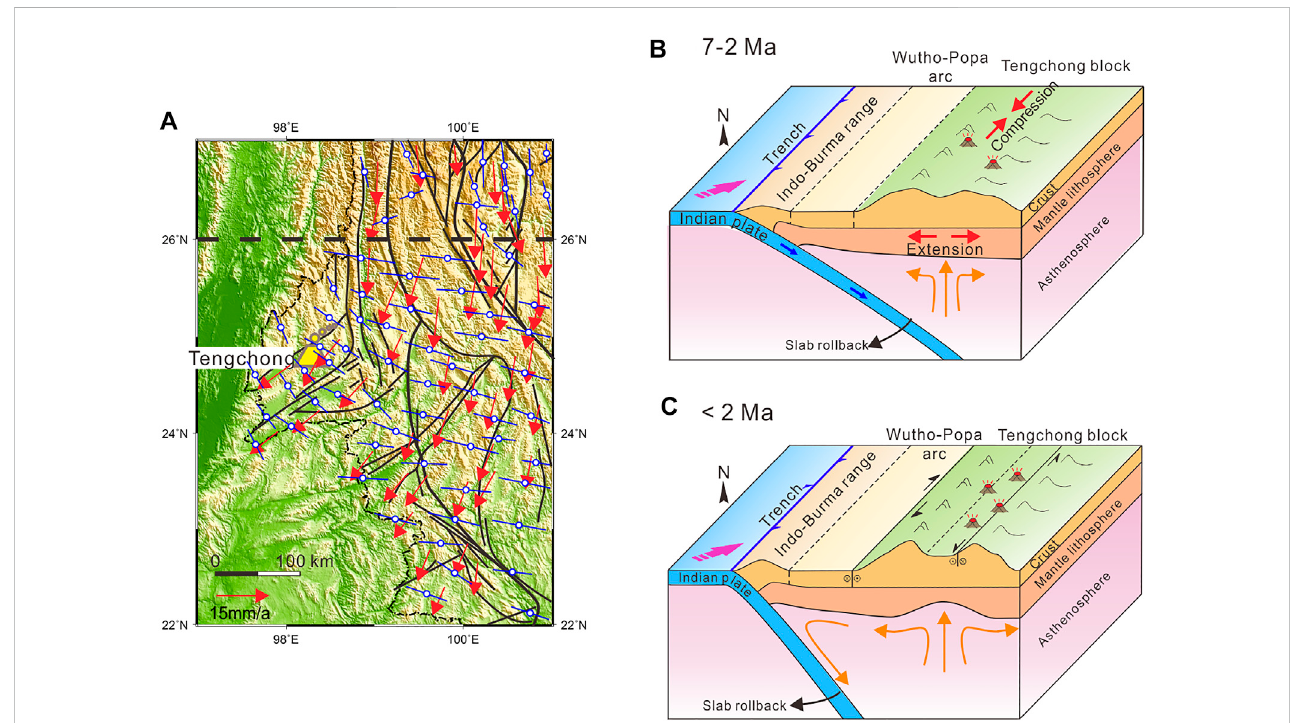
FIGURE 11 (A) Diagrams comparing GPS velocity vectors (red arrows; Wang, 2009) and average XKS fast orientations (blue bars; Gao et al., 2020). The black dashed line (~26 ° N) shows the inferred transition of mantle anisotropy in this area, and black lines denote major faults. (B,C) Schematics of crust – mantle decoupling beneath the Tengchong volcanic fi eld. The eastward underthrusting of the Indian plate following India-Asia collision at 55 – 50 Ma has resulted in the volcanism in Tengchong at 8 Ma. The crust experienced NNE ‒ NE-oriented compression, while the lithospheric mantle underwent WNW ‒ NW-oriented extension due to slab rollback of the Indian plate (Lee et al.,